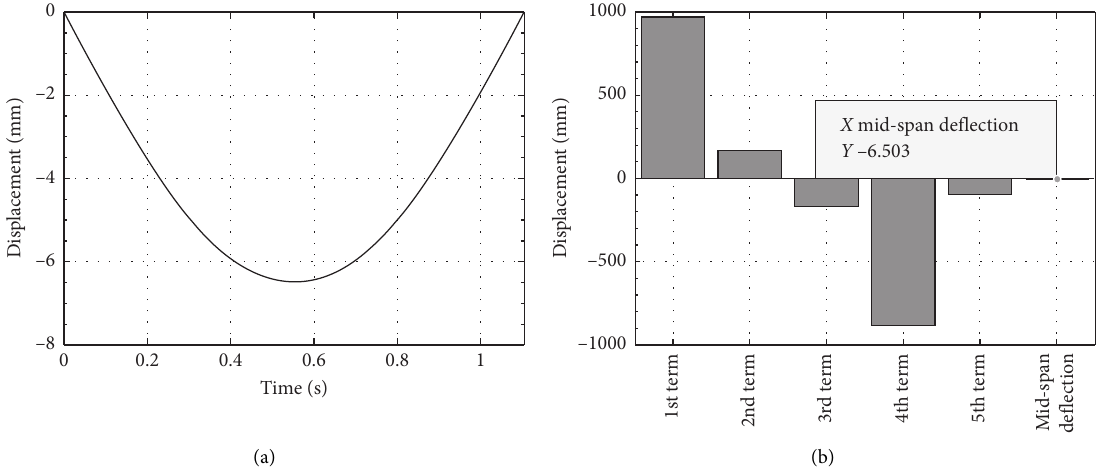
Figure 4: (a) Solution of equation (2) using the parameters in Table 2. (b) Categorical plot of the five terms contributing to the midspan deflection ( ≈ 6 mm) with the same order displayed in equation